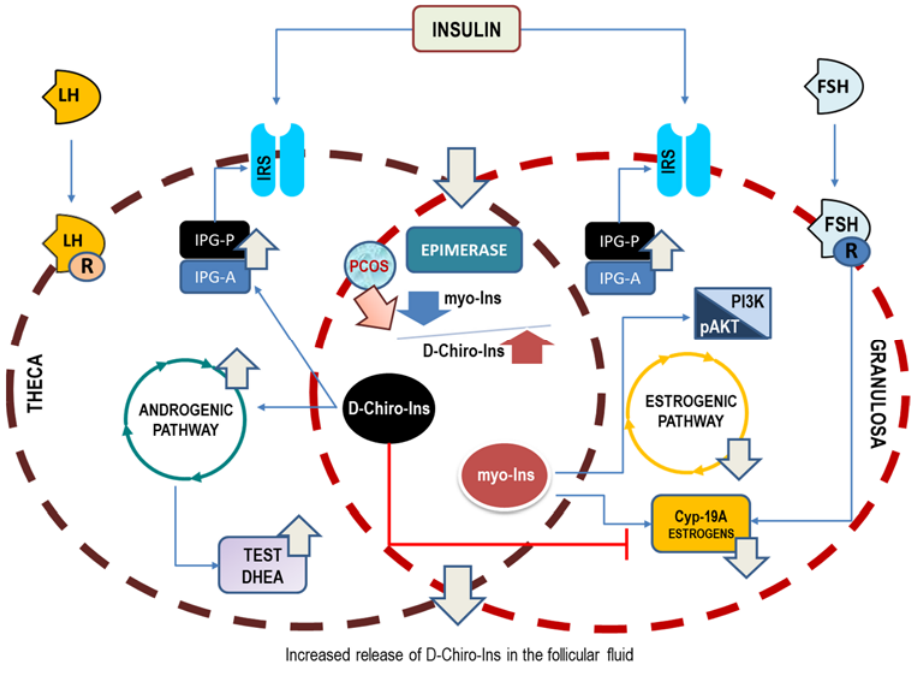
Figure 2. Opposite effects upon ovary steroidogenesis of myo-Ins and D-Chiro-Ins. Insulin stimulation promotes the release of phosphoglycans, containing either myo-Ins (IPG-A) or D-Chiro-Ins (IPG-P). Moreover, insulin activates the epimerase-dependent transformation of myo-Ins into D-Chiro-Ins. Test, testosterone; DHEA, dehydroepiandrosterone; Cyp-19A, aromatase.